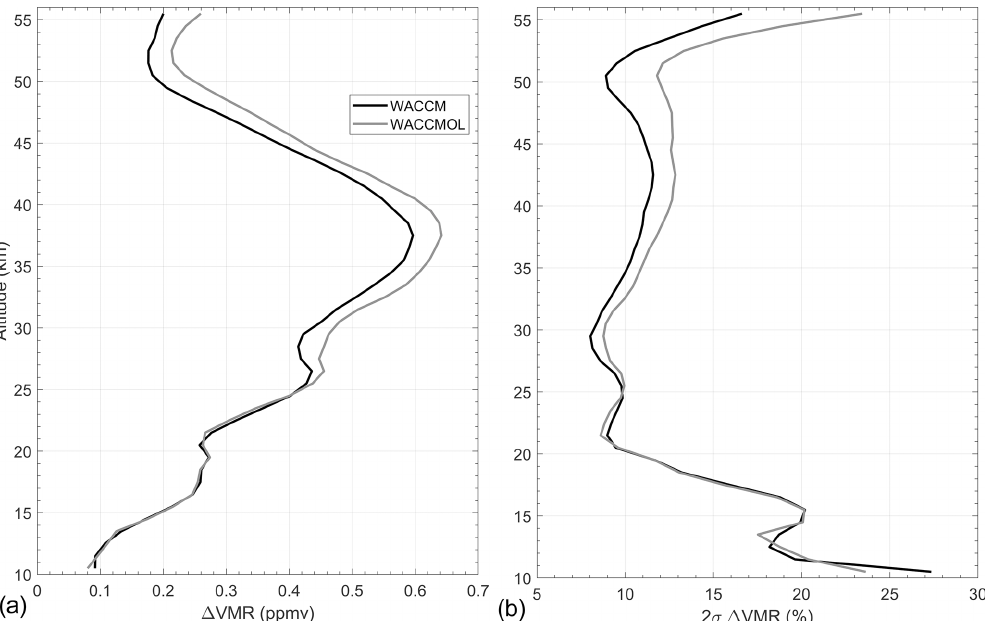
Figure 2. Simulated 2 σ variability (a) and relative 2 σ variability (b) for ACE-FTS–OSIRIS-coincident O 3 profiles when interpolating to measurement geolocations from WACCM grid (black) and using WACCMOL (WACCM output at observed locations; grey). Coincidence criteria of within 6h and 500km.